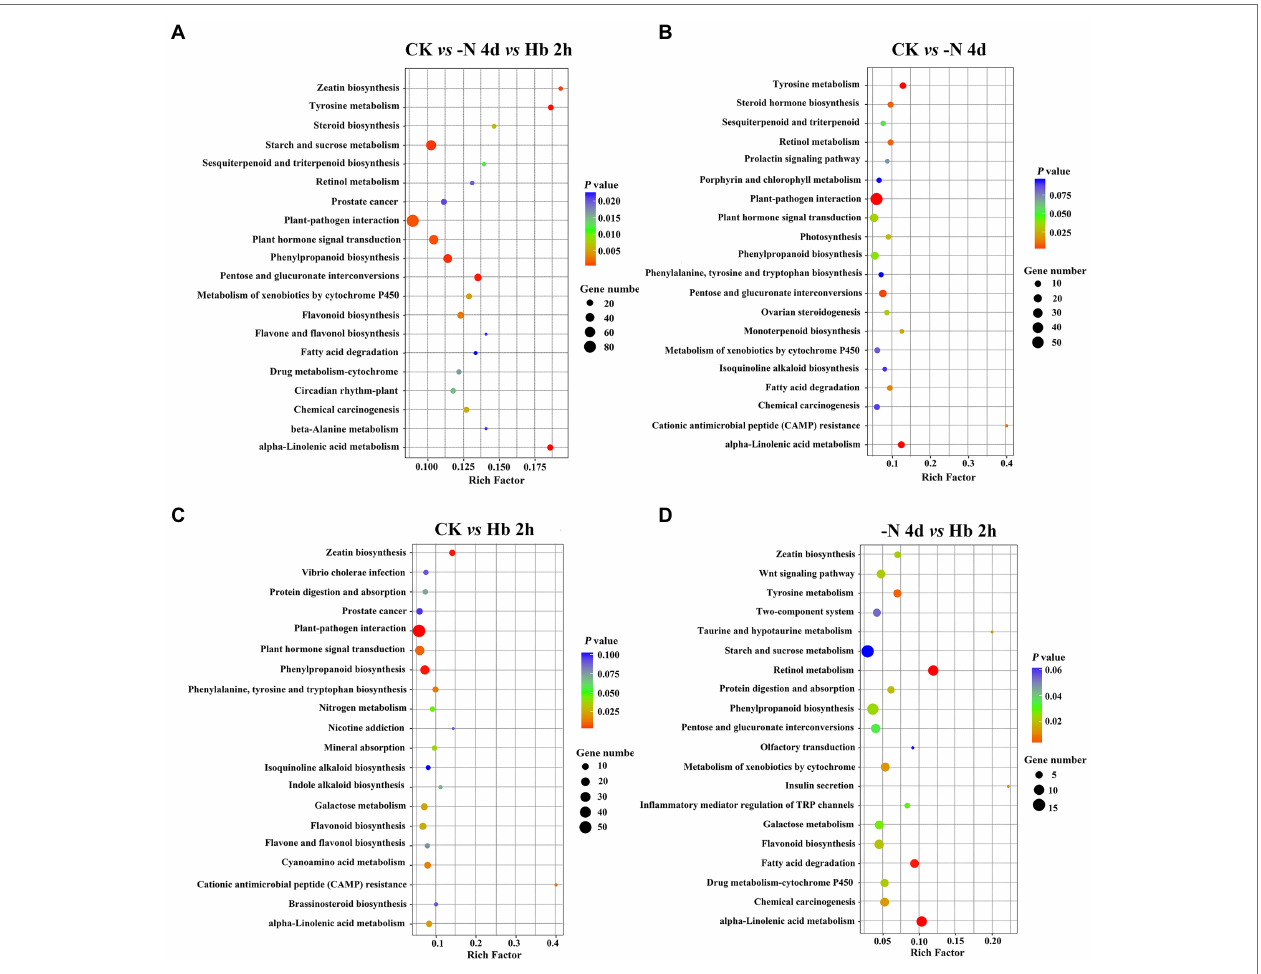
FIGURE 3 | Enrichment of DEGs for the top 20 KEGG pathways in C. sinensis roots in CK, -N 4d, and Hb 2 h groups. (A) CK vs -N 4d vs Hb 2 h; (B) CK vs -N 4d; (C) CK vs Hb 2 h; (D) -N 4d vs Hb 2 h. A larger rich factor value denotes a higher degree of enrichment. A lower value of p represents more significant enrichment of the